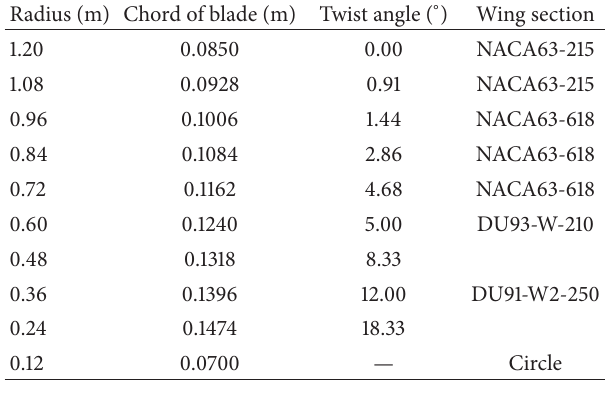
Table 1: Wind turbine blade configuration. Radius (m) Chord of blade (m) Twist angle ( ∘ ) Wing section